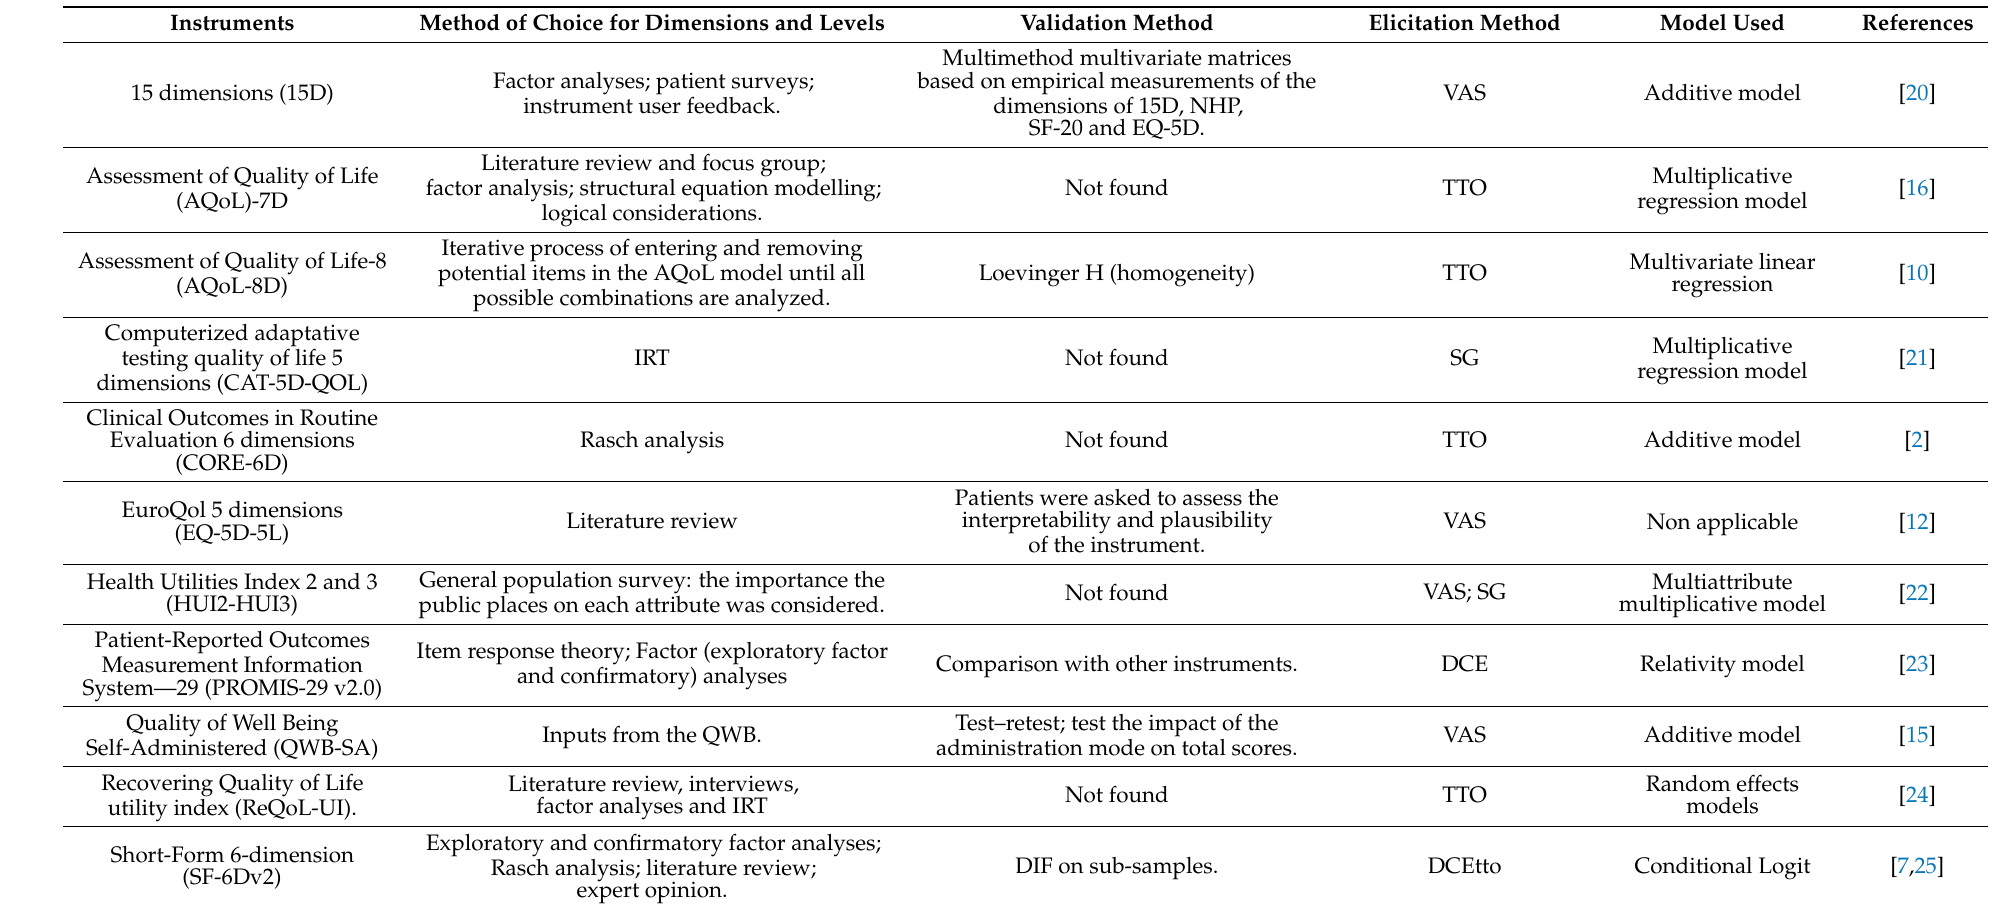
Table 2. Methods used for the development of generic